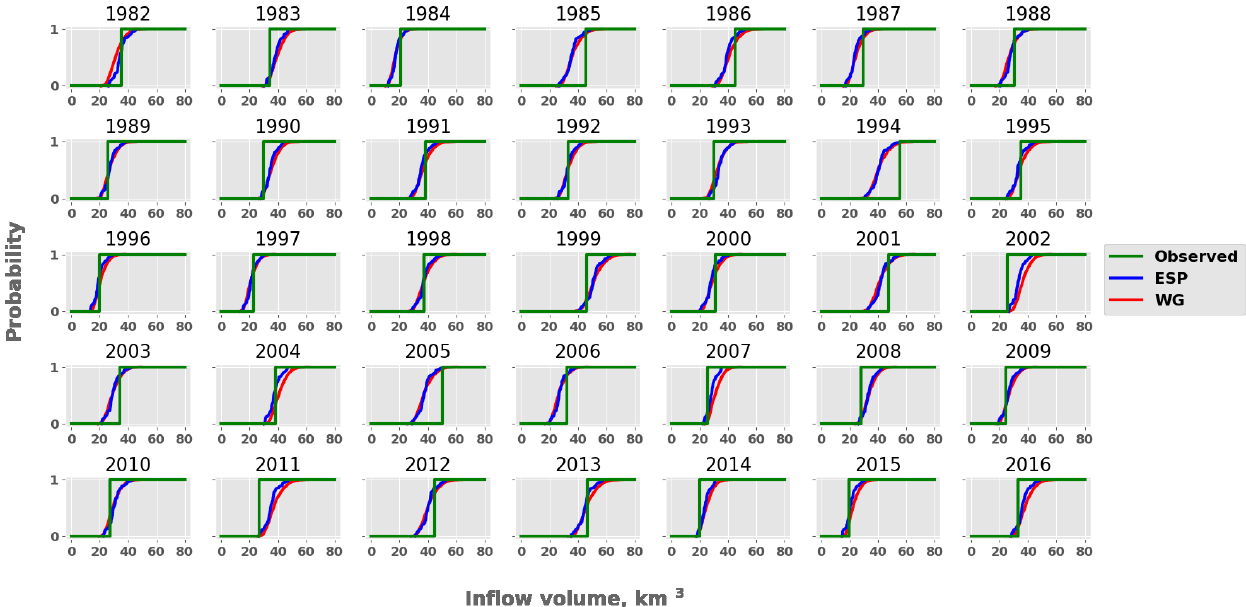
Figure 9. Cumulative probability distribution functions for W in April–June for all years between 1982 and 2016. The green line represents the observed inflow, the blue line represents the ESP-based forecast and the red line represents the WG-based forecast.